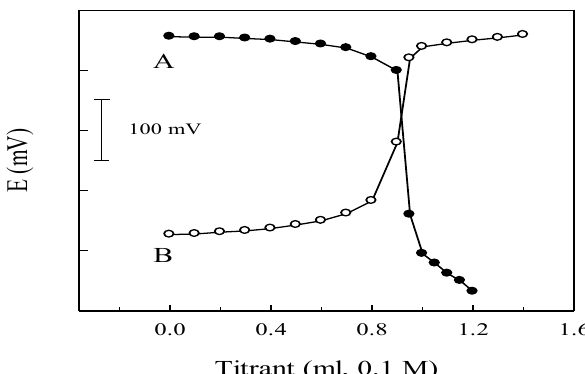
for potentiometric titration 2